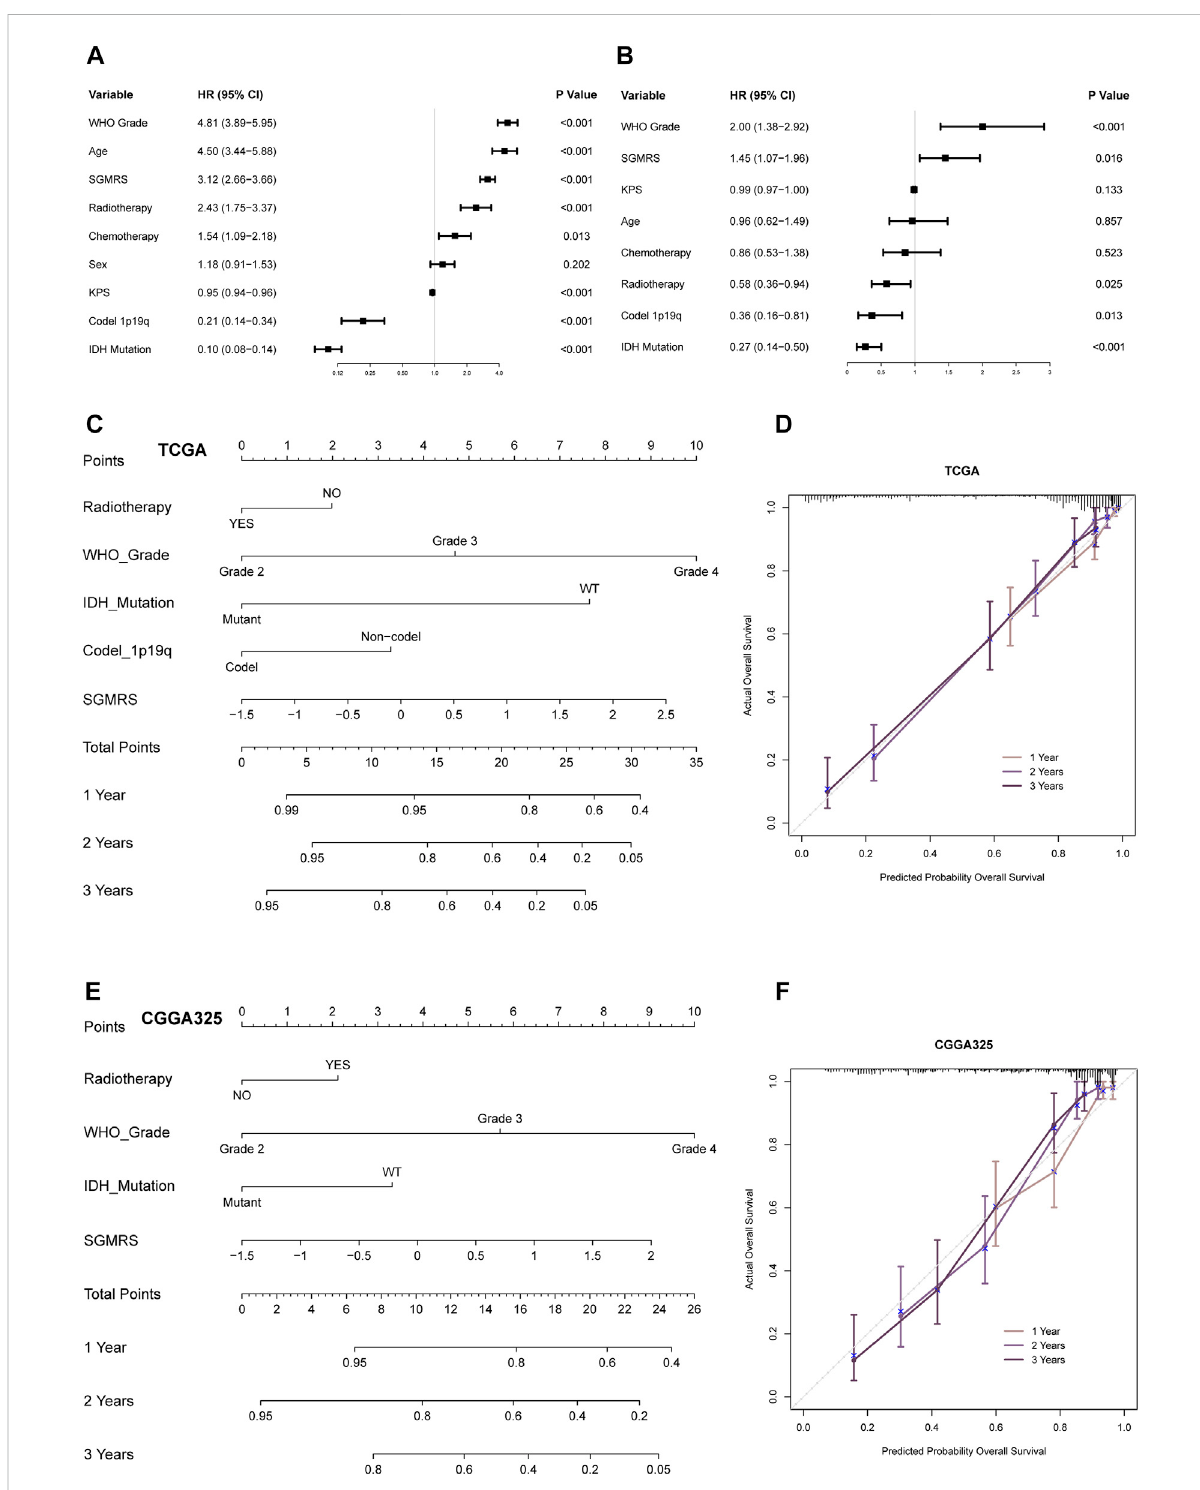
FIGURE 7 Prognosticvalue of SGMRS and construction of SGMRS-based nomograms. (A) Univariate analysis of potential prognostic factors in glioma. (B) Multivariateanalysistoidentifyindependentprognosticfactorsinglioma. (C) Nomogramof1-,2-,and3-yearsurvivalrateofgliomapatientsinTCGA cohort. (D) Calibration plots for the nomogram of TCGA cohort. (E) Nomogram of 1-, 2-, and 3-year survival rate of glioma patients in CGGA325 cohort. (F) Calibration plots for the nomogram of CGGA325